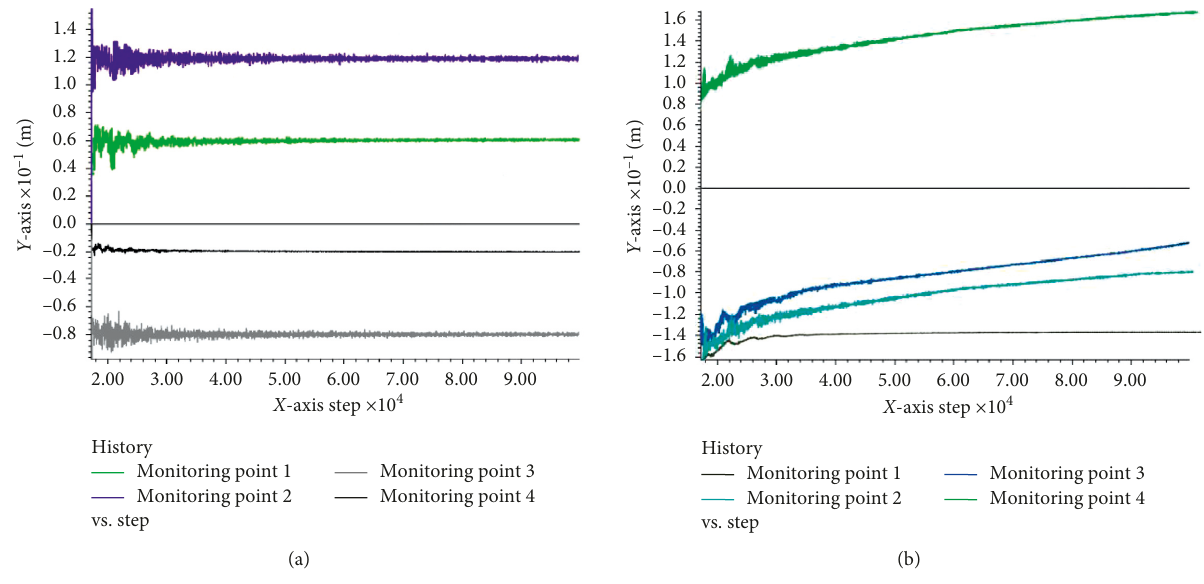
vs. Figure 6: Displacement response diagrams after six dynamic loads. (a) X -direction displacement and (b) Z -direction